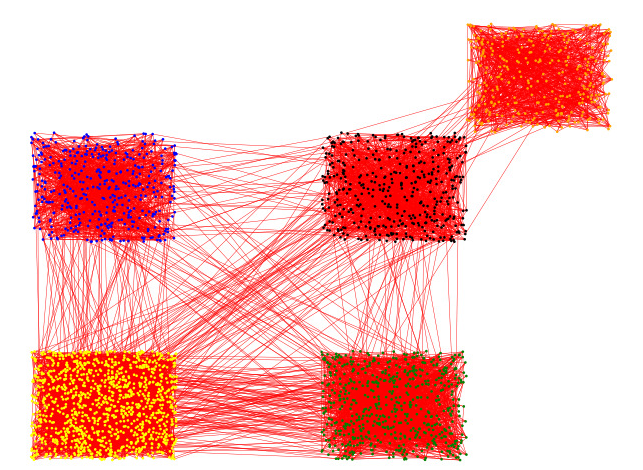
Figure 6. The newly formed network after the COVID-19 field is added. The yellow dot represents the articles in field a , the green dot represents the article in field b , the blue dot represents the article in field c , the orange dot represents the article in field d , and the black dot represents the article in the COVID-19 field. Points in the network are connected by red